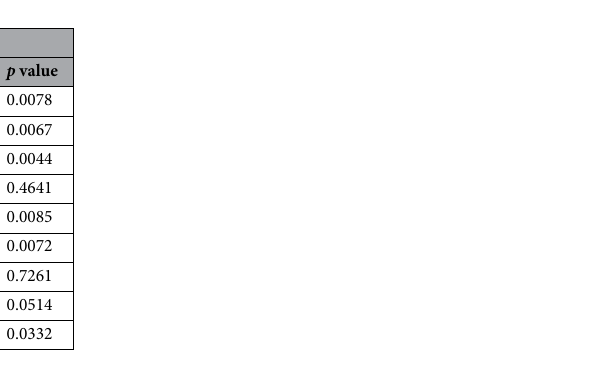
Figure 4. Effect of VP on DD nodule-derived fibroblasts (n = 7). mRNA expression of COL1A1, COL3A1, COL4A1, FN1EDA, ACTA2, PLOD2, YAP1, CCN2 and SERPENI1 relative to YWHAZ; the cells were treated with 5 ng/ml of TGF-β1 stimulation for 96 h including a 48 h treatment with VP (with DMSO as control).